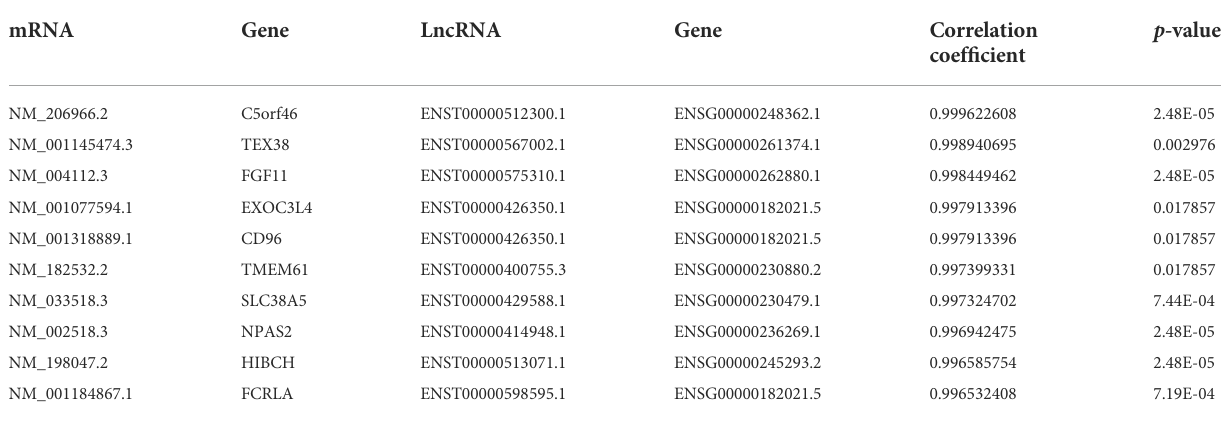
TABLE 5 The top 10 co-expression